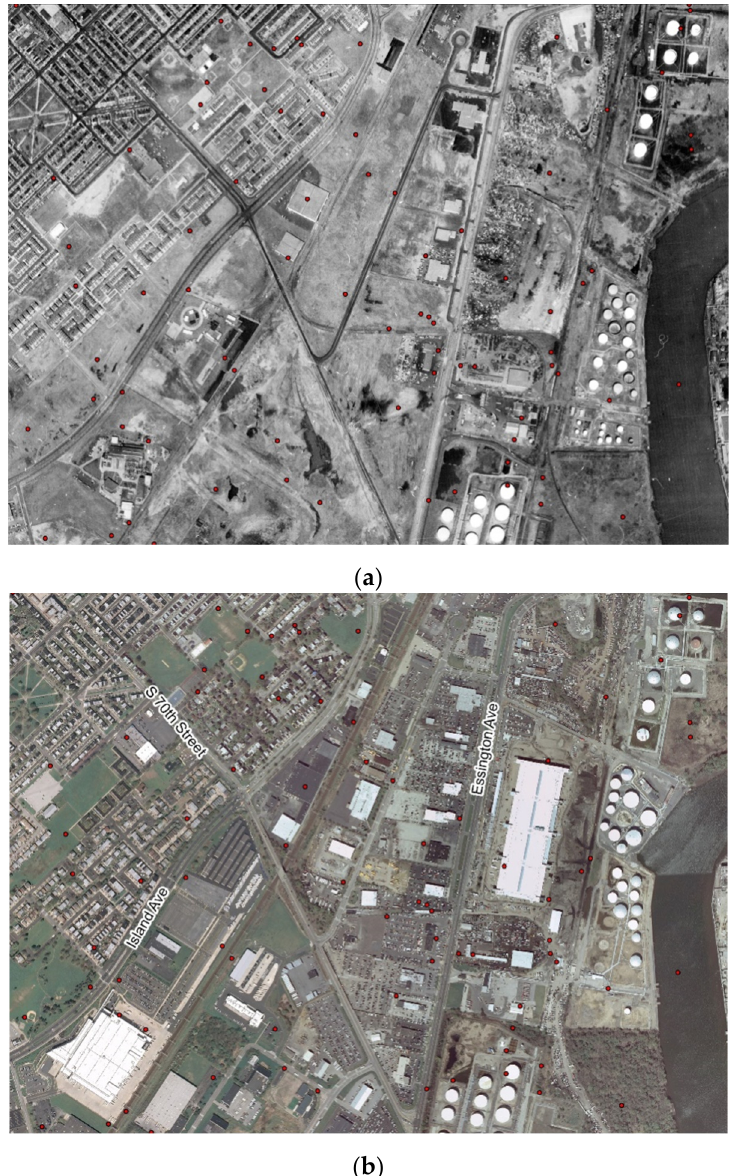
Figure 4. Aerial imagery from 1970 ( a ) and 2010 ( b ) for the Lower Southwest district in the vicinity of the Philadelphia Wholesale Produce Market and Paschall Playground. These images illustrate an area where herbaceous cover was replaced with buildings and other impervious cover. Red dots are points that were interpreted for land cover.